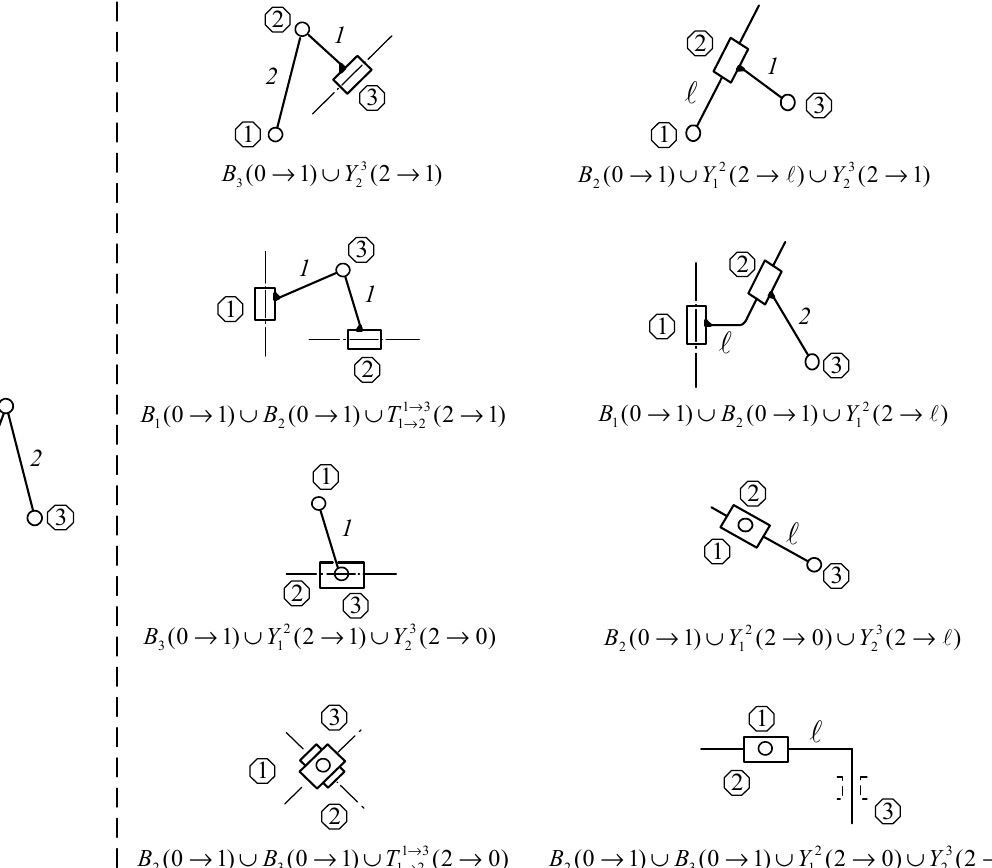
Figure 9. Relationship between d 6 and x.